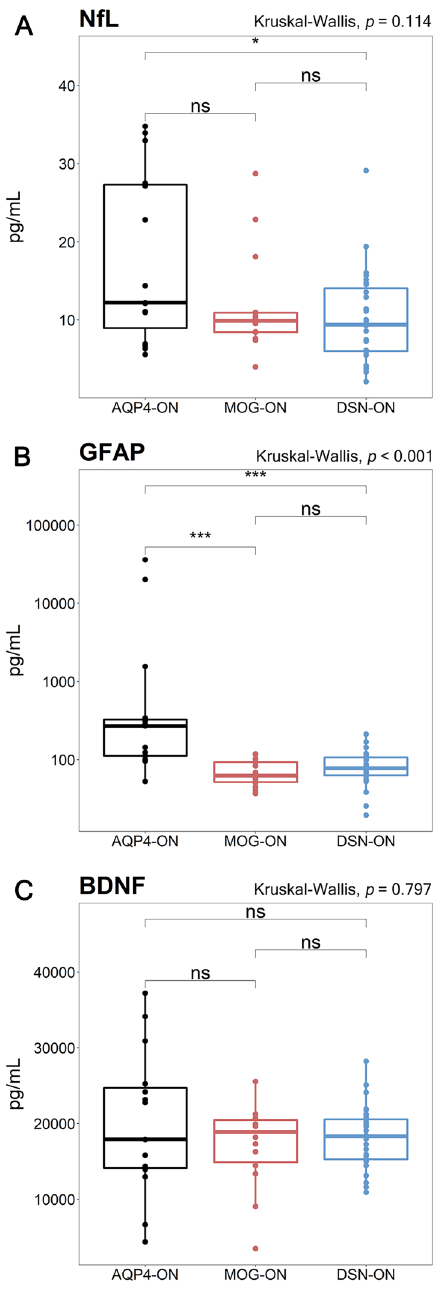
Figure 1. Comparison of serum biomarkers in patients with AQP4-ON, MOG-ON, and DSN-ON. Serum ( A ) NfL, ( B ) GFAP, and ( C ) BDNF levels were compared according to ON etiology at baseline. Boxes represent median and IQR. Posthoc analysis was performed with Bonferroni correction. * p < 0.05, *** p < 0.001. ns not significant, AQP4-ON optic neuritis with aquaporin-4 antibody, BDNF brain-derived natriuretic factor, DSN-ON double-seronegative optic neuritis, GFAP glial fibrillary acidic protein, IQR interquartile range, MOG-ON optic neuritis with myelin oligodendrocyte glycoprotein antibody, NfL neurofilament light chain, ON , optic